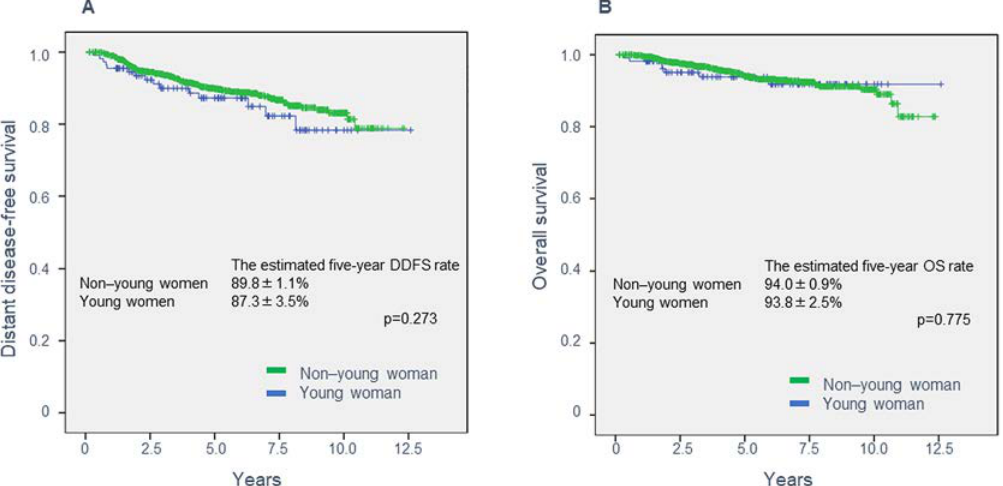
Figure 2 Distant disease-free and overall survival for 1,130 women with breast cancer. (A) Distant disease-free survival and (B) overall survival by age